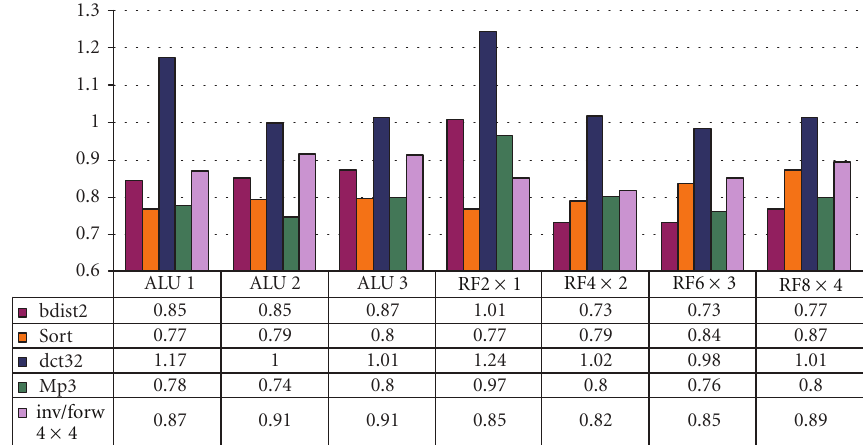
Figure 12: Relative execution time for nonpipelined data paths generated for di ff erent resource constraints.